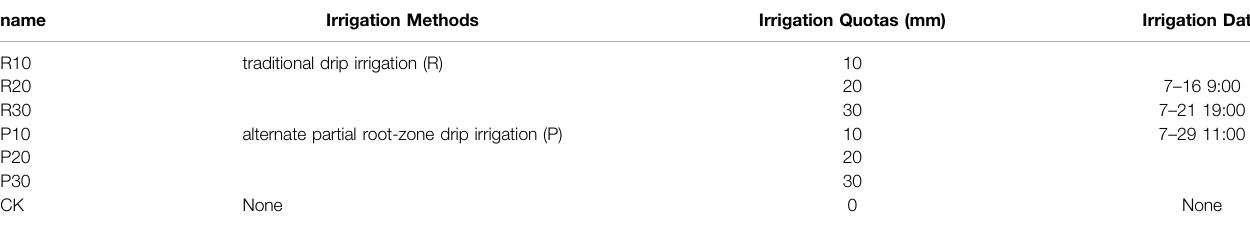
TABLE 1 | The irrigation strategies of alfalfa during the study